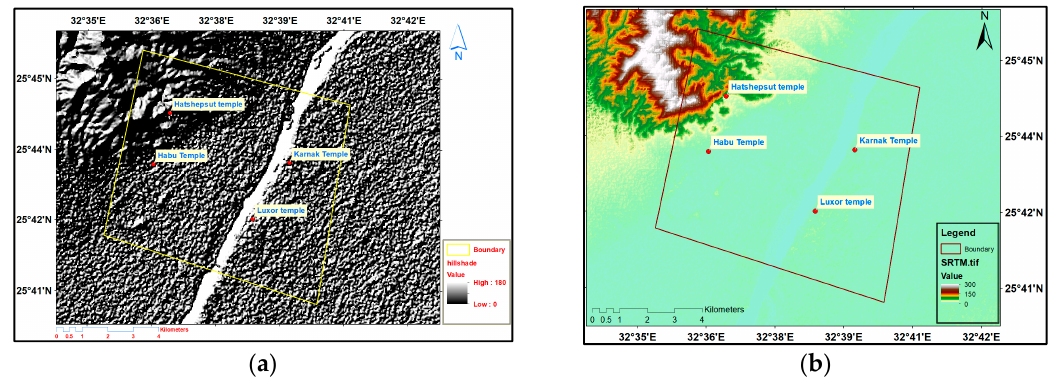
Figure 6. Hill shade ( a ) and two-dimensional (2D) ( b ) showing the topographic and elevation properties around the study area.